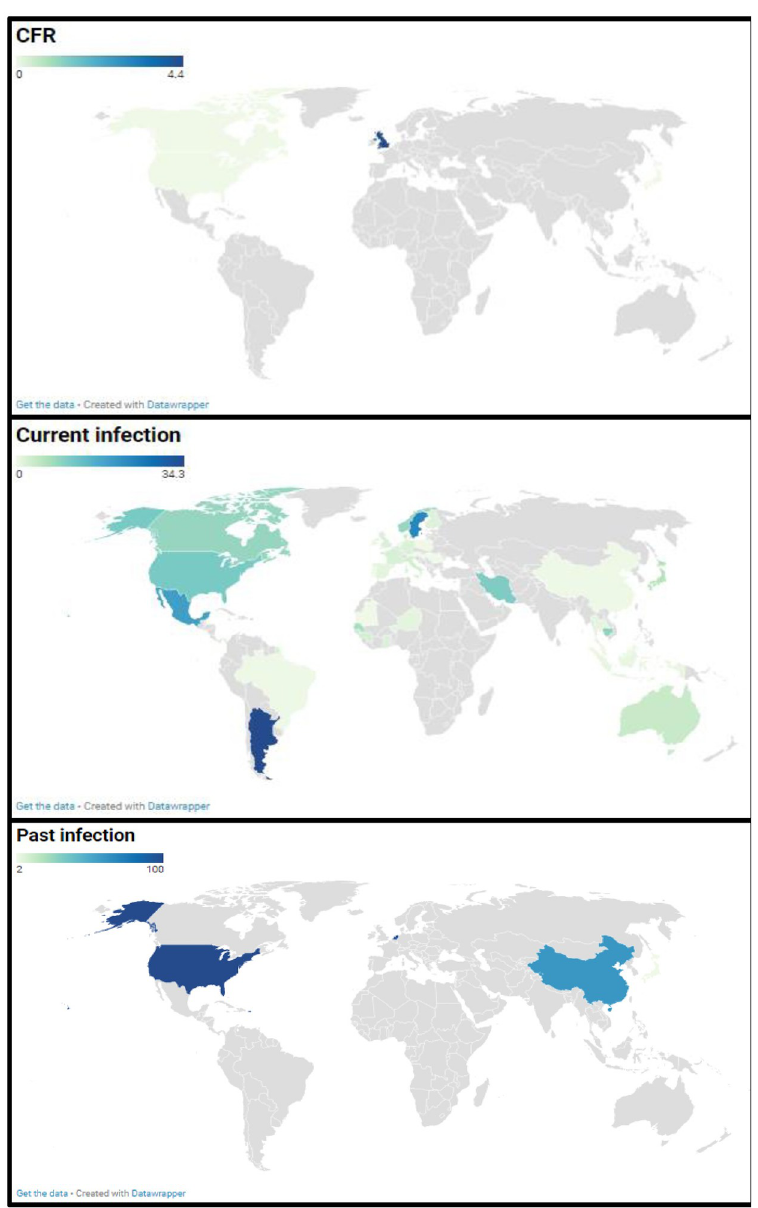
Fig 2. Global distribution, case fatality rate, and prevalence estimate of Enterovirus D68 current and past infections. The figures represent from top to bottom: the Enterovirus D68 case fatality rate and the prevalence of Enterovirus D68 current and past infections. Map source: https://www.datawrapper.de/basemaps/world/.